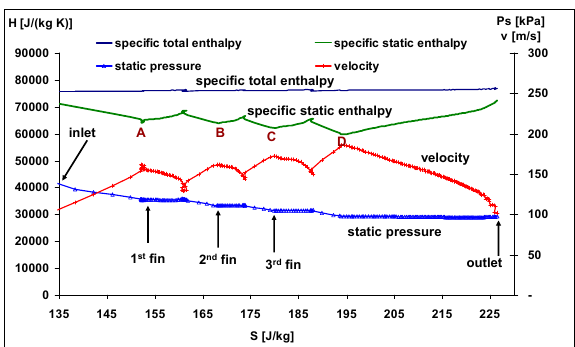
Figure 5. Enthalpies, static pressure and velocity variation in the labyrinth seal as a function of entropy at 12 g/s.